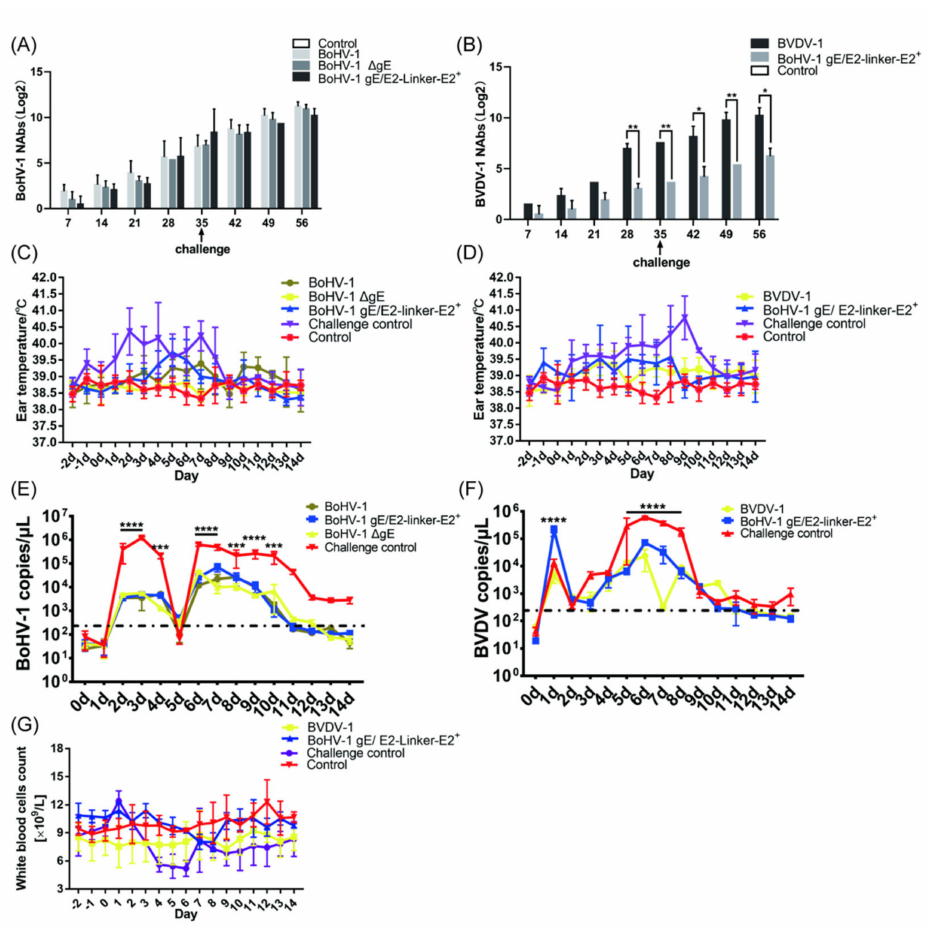
and BoHV − 1 gE/E2 − Linker − E2 + immunization group did not significantly differ from that of the BoHV − 1 immunization group. On day 28, the average serum-neutralizing titer of the calf in the BoHV − 1 immunization group reached 72.30. On day 42, the av- erage serum-neutralizing titer of the calf in the BoHV − 1, BoHV − 1 ∆ gE, and BoHV − 1 gE/E2 − Linker − E2 + immunization groups reached 489.50, 337.59, and 387.63, respectively (Figure 5A). The final neutralizing titer of the BoHV − 1 immunization group was not significantly different from that of the BoHV − 1 gE/E2 − Linker − E2 + and BoHV − 1 ∆ gE im- munization groups. Similarly, BVDV − 1 and BoHV − 1 gE/E2 − Linker − E2 + immunization groups became positive in serum 7 days after immunization. The average serum-neutralizing titer of calves after 42 days was highest at 337.59 and 21.82, respectively. The neutralizing titer of the BoHV − 1 gE/E2 − Linker − E2 + immunization group was significantly different from that of the BVDV − 1 immunization group (Figure 5B). Importantly, all immunization groups showed intense neutralizing activity against BoHV − 1 infection in calves, producing a final titer comparable to the neutralizing titer induced by parent BoHV − 1. At the same time, the E2-Linker-E2 protein expressed by BoHV − 1 gE/E2 − Linker − E2 + could cause calves to produce neutralizing antibodies against BVDV − 1 infection.